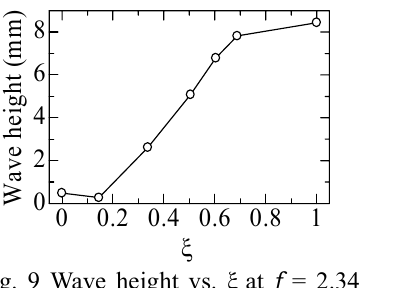
Fig. 9 Wave height vs. ξ at f = 2.34 Hz.